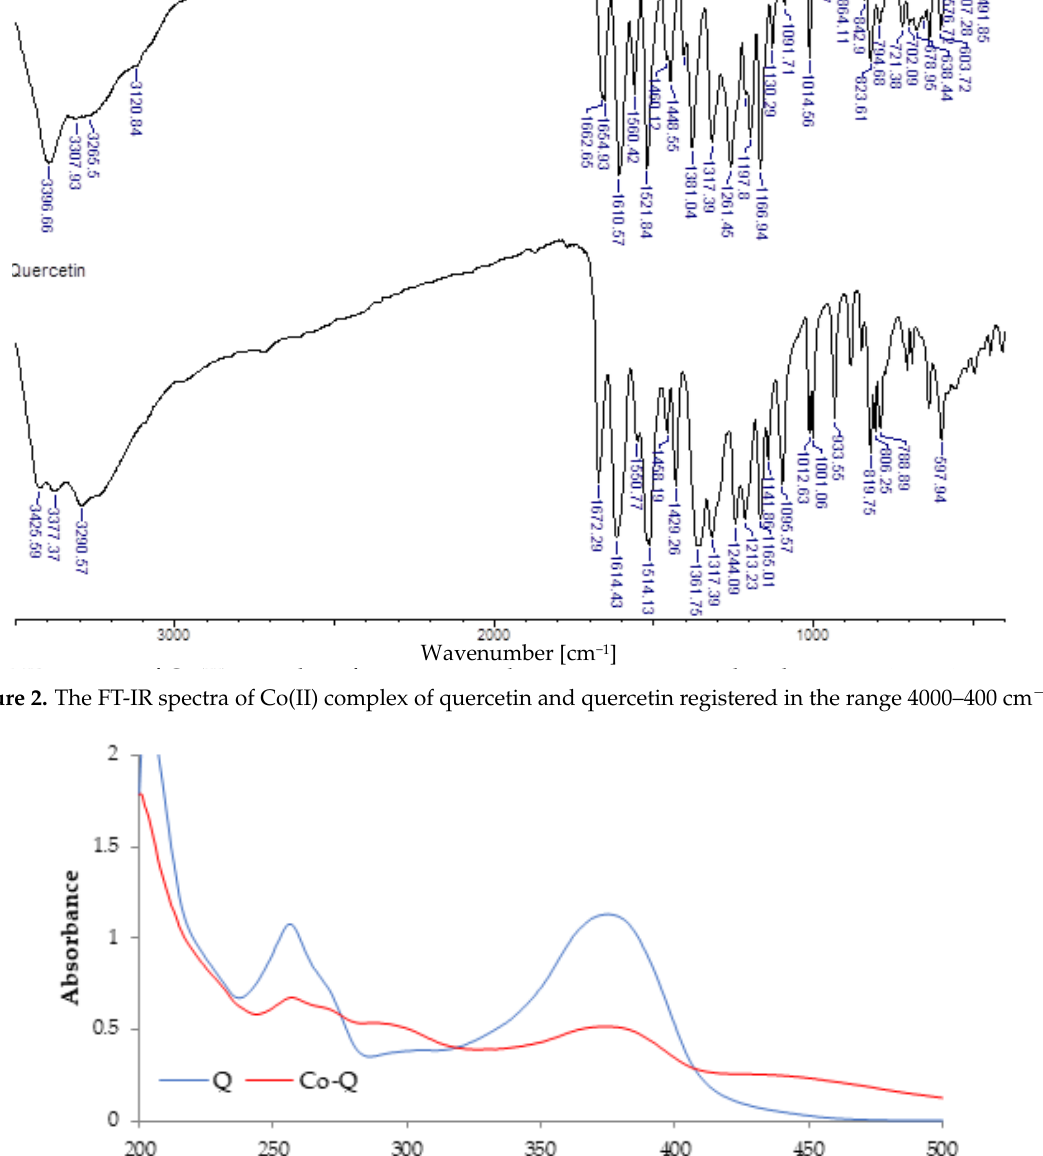
Figure 4. Curve of the dependence of the maximum absorbance in the UV/Vis electronic spectra on the composition of the cobalt(II)-quercetin complex registered in Tris-HCl buffer (pH = 7.4). The analysis of infrared spectra of the cobalt with quercetin complex indicates the participation of the carbonyl group and the hydroxyl group, from the B ring, in the for- mation of the complex. Moreover, the decrease in the absorbance of band I and II in the UV/Vis spectra of the complex also suggests the participation of catechol moiety and the carboxyl group in metal ion bonding [40]. Having taken into account the results of the elemental analysis (1:2 molar ratio of metal:ligand), the proposed structure of Co(II)-quer- cetin is shown in Figure 5. The central ion attaches two ligand molecules via chelate bonds involving the carbonyl group and the deprotonated hydroxyl group of the quercetin py- ron ring. The central ion also co-ordinates the two water molecules. The way in which the ligand coordinates metal is the same as described by other authors [41]. The catechol moi- ety is probably engaged in the metal bonding and may therefore lead to polymeric struc- tures being formed.